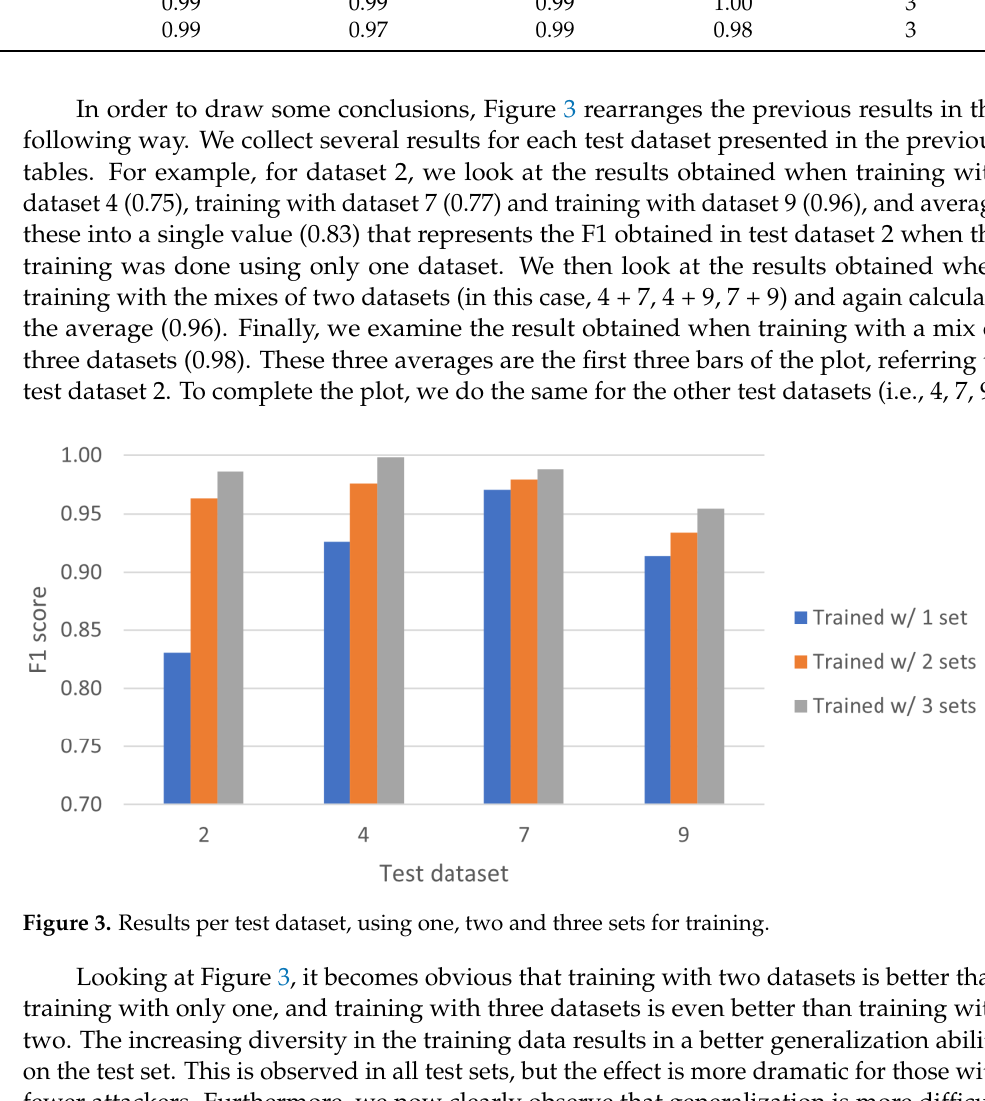
( d ) Figure 4. ROC curves for each experiment in Table 7. ( a ) Training with datasets 2 + 4 + 7 and test with dataset 9; ( b ) Training with datasets 2 + 4 + 9 and test with dataset 7; ( c ) Training with datasets 2 + 7 + 9 and test with dataset 4; and ( d ) Training with datasets 4 + 7 + 9 and test with dataset 2.